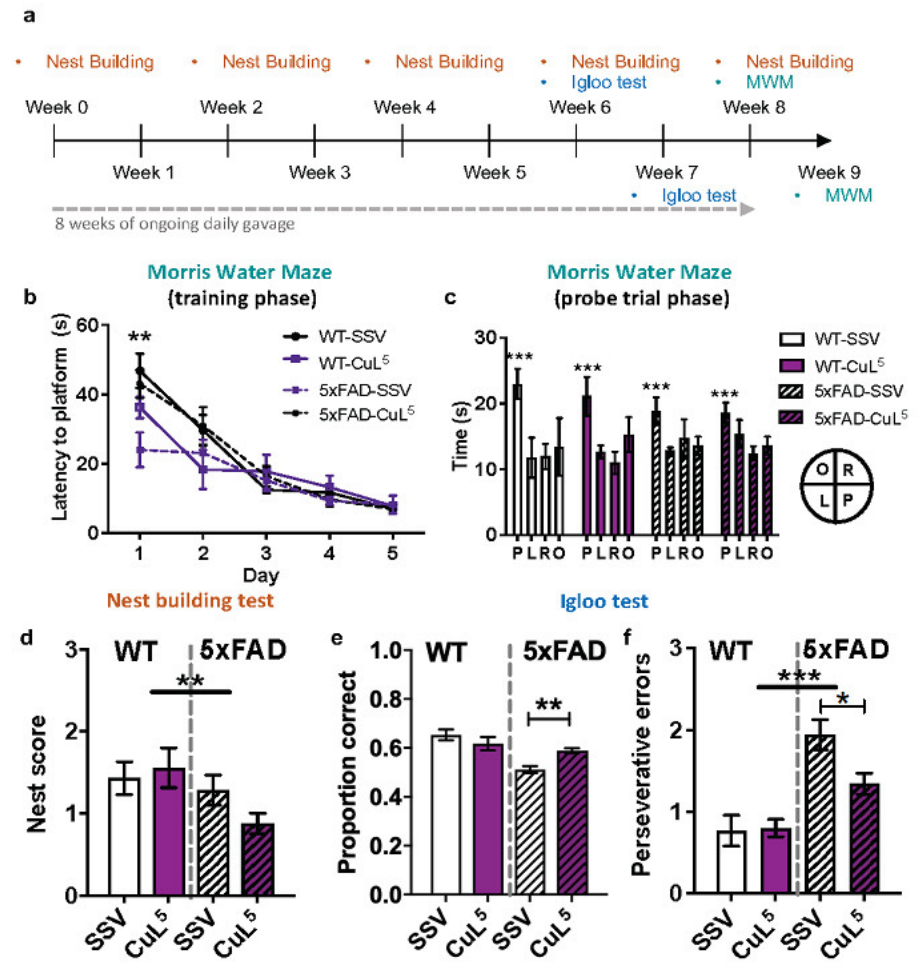
Figure 5. Effect of CuL 5 treatments on 5xFAD cognitive functions. ( a ) Timeline for behavioural testing of CuL 5 -treated mice. SSV or CuL 5 (30 mg/kg) were delivered to non-transgenic (WT) or 5xFAD mice by oral gavage, once daily, for 8 weeks while also being to a battery of behavioural tests to assess the effect of treatment ( n = 6–7 per treatment group). ( b ) Escape latency in the Morris water maze during the training phase. ( c ) Time spent in the former platform quadrant (P) and quadrats opposite (O), to the left (L), and to the right (R) of the platform during the probe trial. ( d ) Nest quality scores. ( e ) Choice accuracy in igloo test. ( f ) Perseverative errors in igloo test. Data for each treatment group are presented as the mean ± S.E.M per treatment group. Morris water maze data and choice accuracy in the igloo test were analysed with two-way ANOVA for repeated measure with Bonferroni pairwise comparisons. Perseverative errors in the igloo test and nest building scores estimated by Poisson regression as incidence rate ratios (IRRs), and by logistic regression as odds ratios (ORs), respectively. */**/*** = p ≤ 0.05/0.01/0.001.